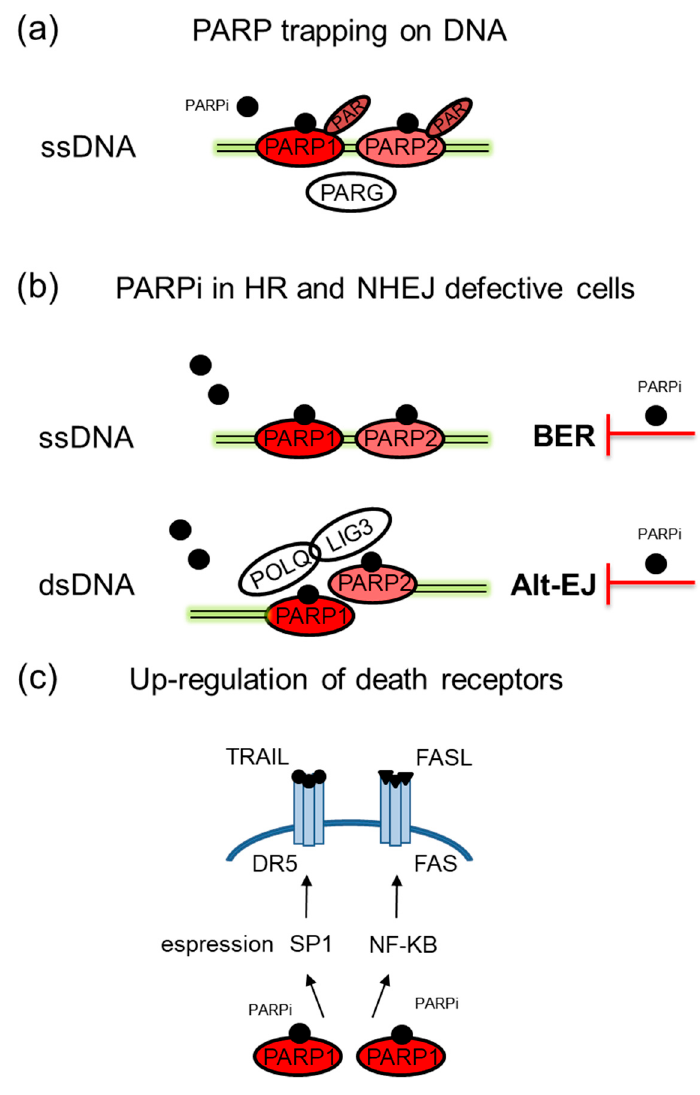
Figure 2. Additional mechanisms of action of PARPi. ( a ) In the presence of PARPi, PARP1/2 trapping on damaged DNA may occur with consequent formation of PARP-DNA complexes that prevent DNA replication and transcription. PARPi vary significantly in their trapping abilities. ( b ) In case of cells defective in HR and NHEJ, PARPi prevent DSB repair by Alt-EJ with induction of cell death. ( c ) PARPi favor up-regulation of death receptors through activation of SP1 and NF-kB transcription factors.